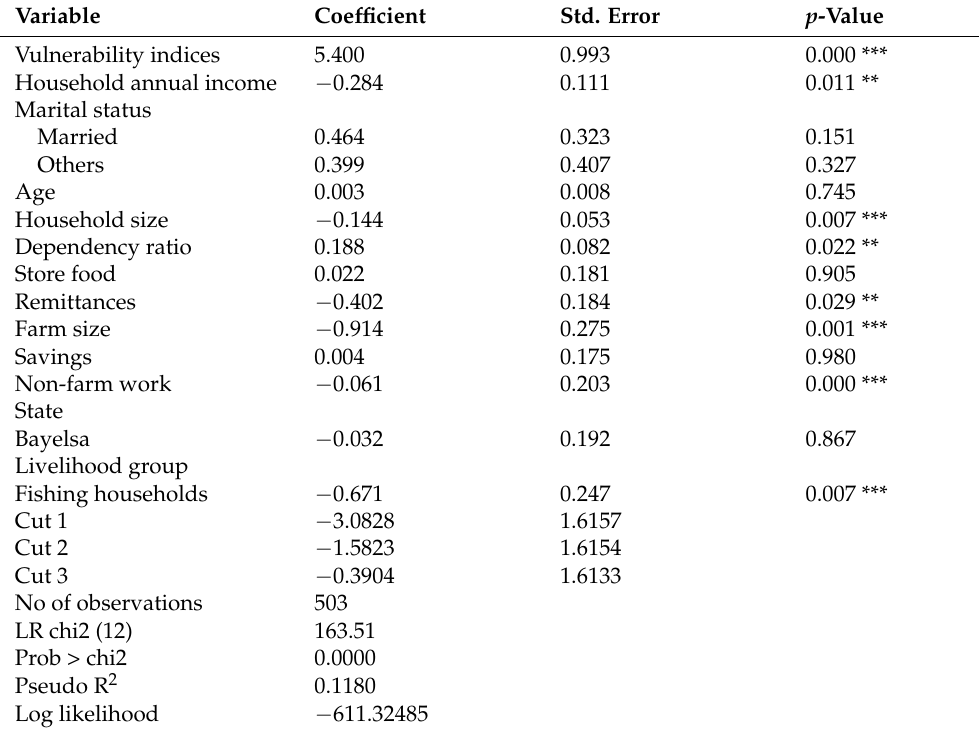
Table 6. Estimated Coefficient of Ordered Logit Model.